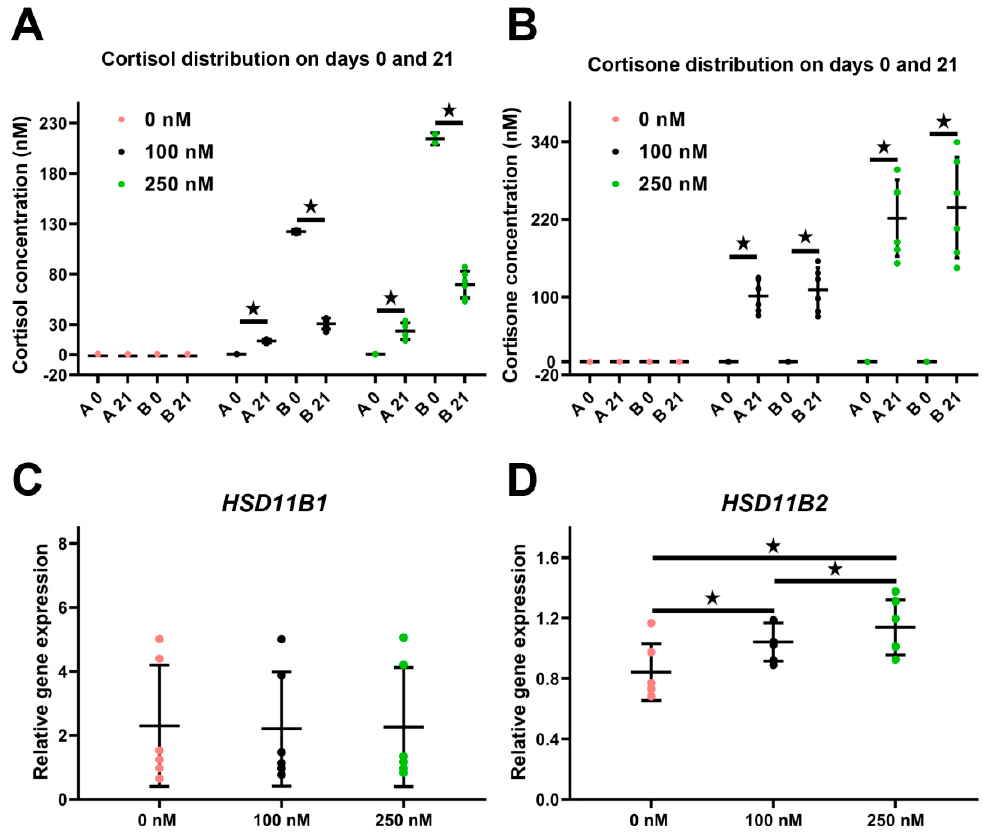
Figure 6. Distribution and metabolism of cortisol and cortisone in ALI-POEC. ( A ) Directional changes of cortisol distribution during treatment; ( B ) rising cortisone levels in apical and basal compartment. Relative mRNA abundance of ( C ) HSD11B1 converting cortisone to active cortisol and ( D ) HSD11B2 inactivating cortisol to cortisone. Data are shown as mean with SD. Asterisks indicate a significant difference at p < 0.05. n = six animals.